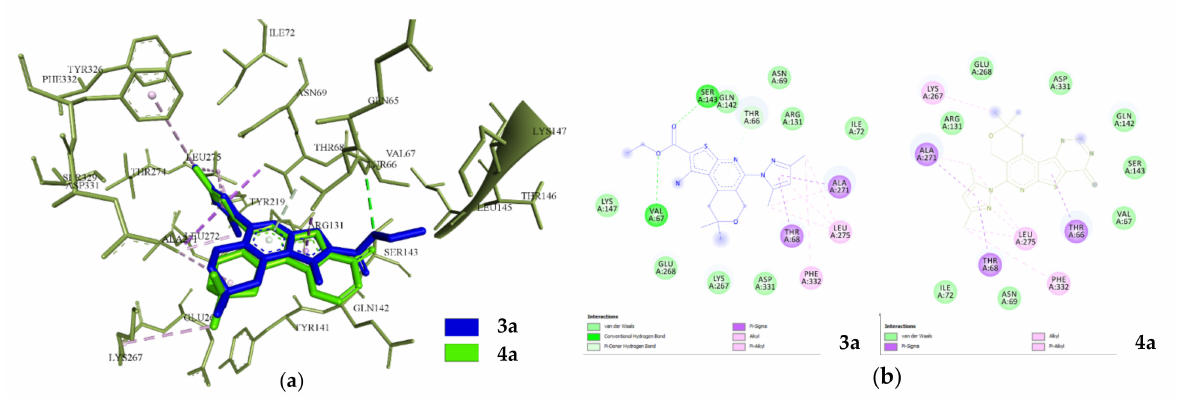
Figure 11. Visualization of interaction of 3a and 4a with 5HT_1A; ( a ) superposition in the ICL interaction interface; ( b ) conformation maps of